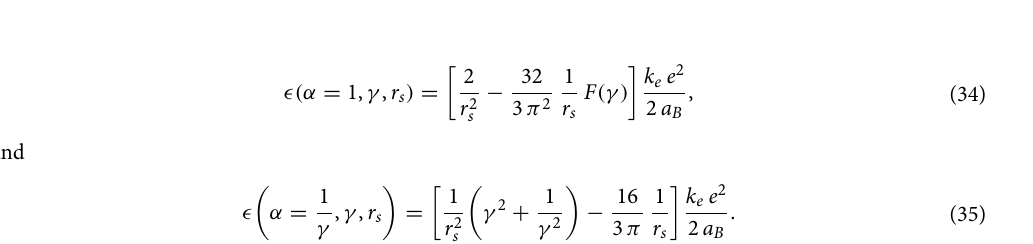
Figure 2. The energy per particle difference, ǫ(α , γ , r s ) 1.0, 1.5, 2.0, 2.5 and 3.0 (from left to right). The energy is measured in units of k e e 2 for values of r s =